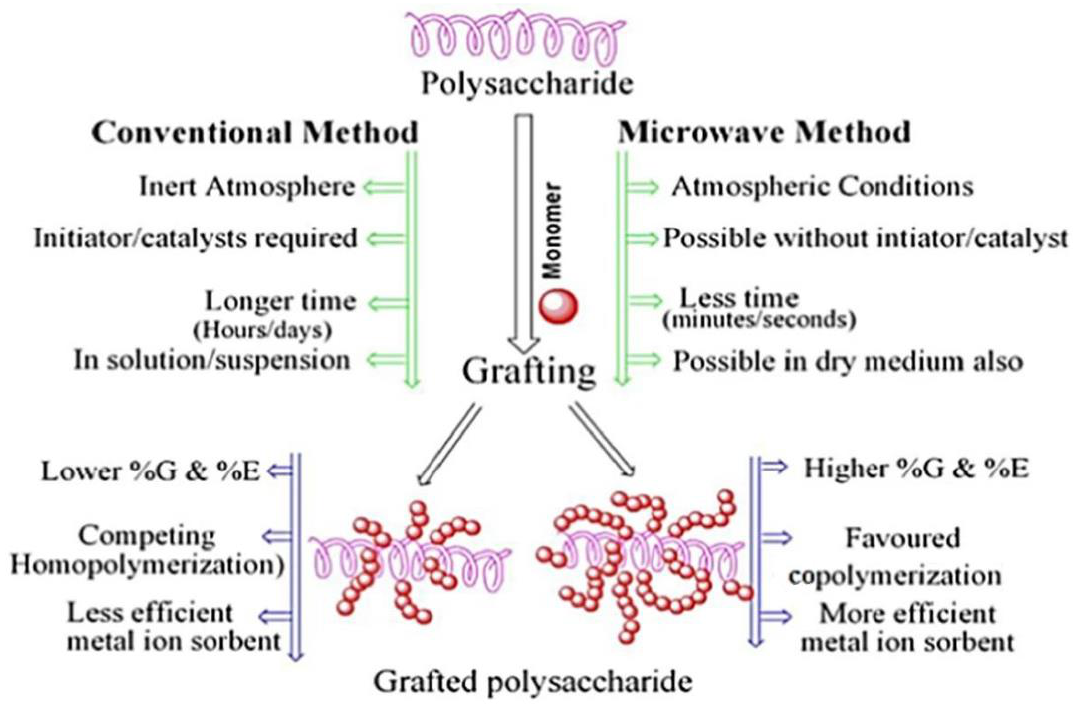
Figure 2. A comparison between conventional graft polymerization and microwave induced graft polymerization routes